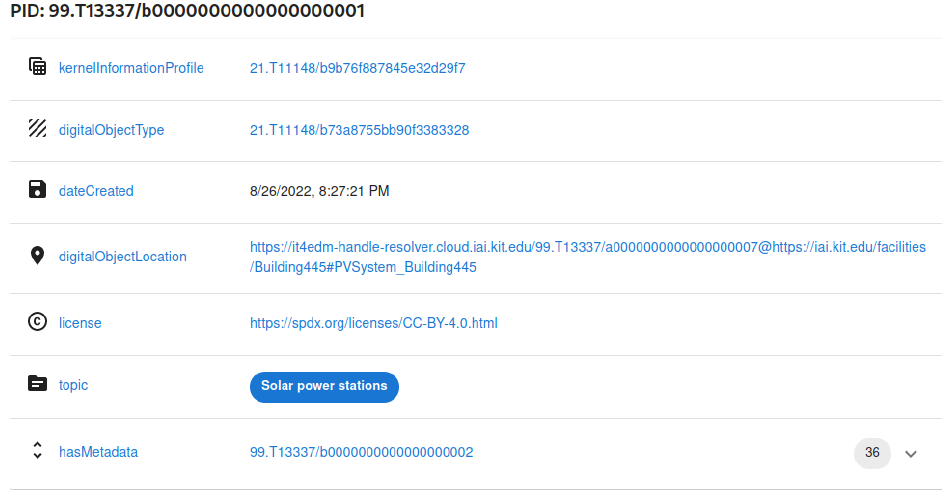
Figure 5. Screenshot of the FDO-Browsers Table View Showing the Properties of an